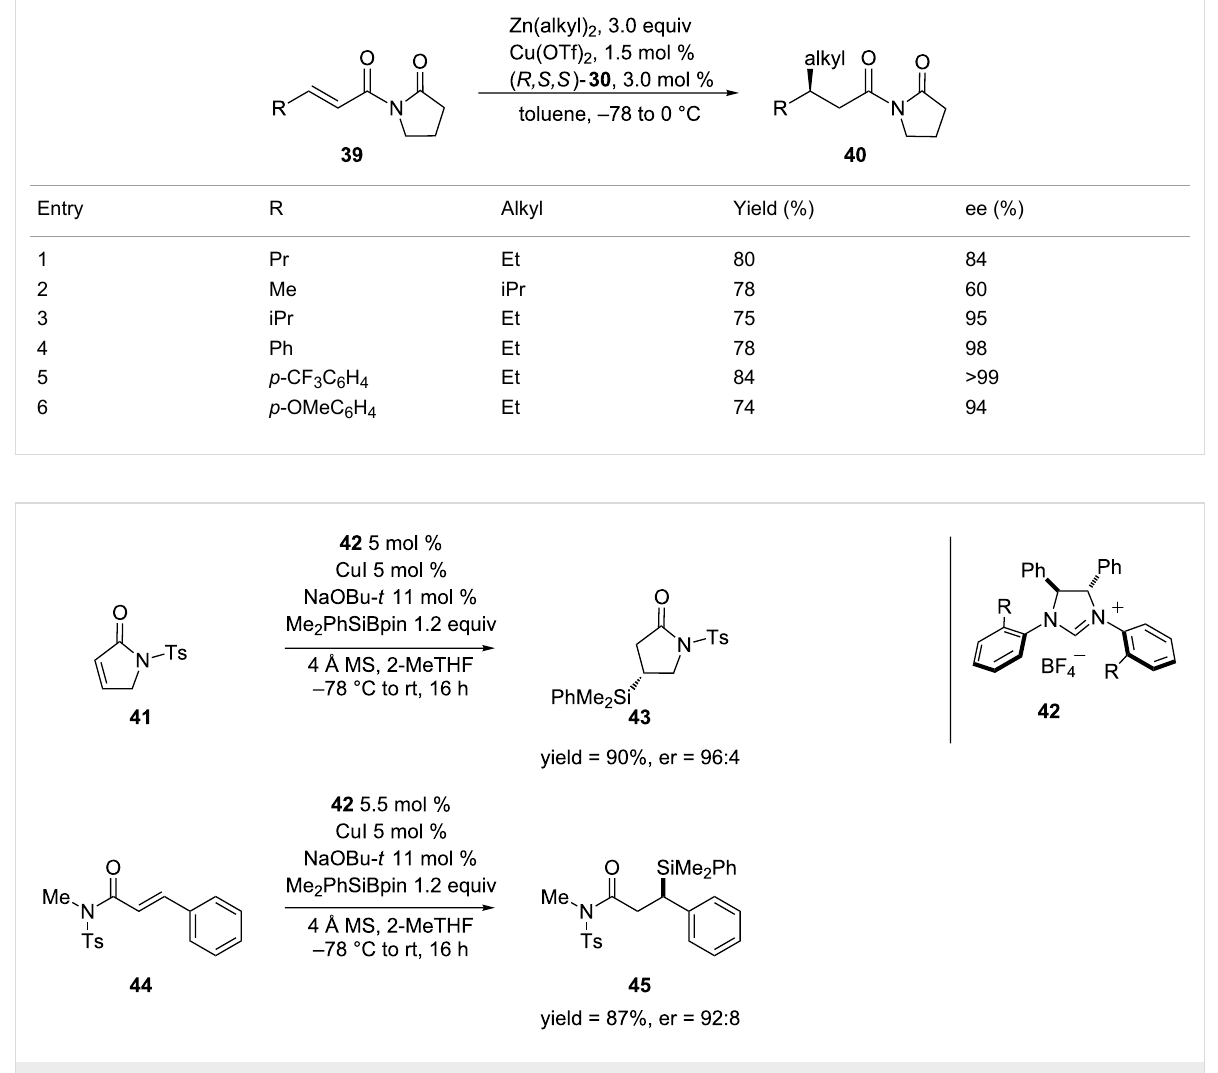
Table 5: Copper-catalyzed asymmetric 1,4-additions of alkylzinc reagents to acyclic α , β -unsaturated